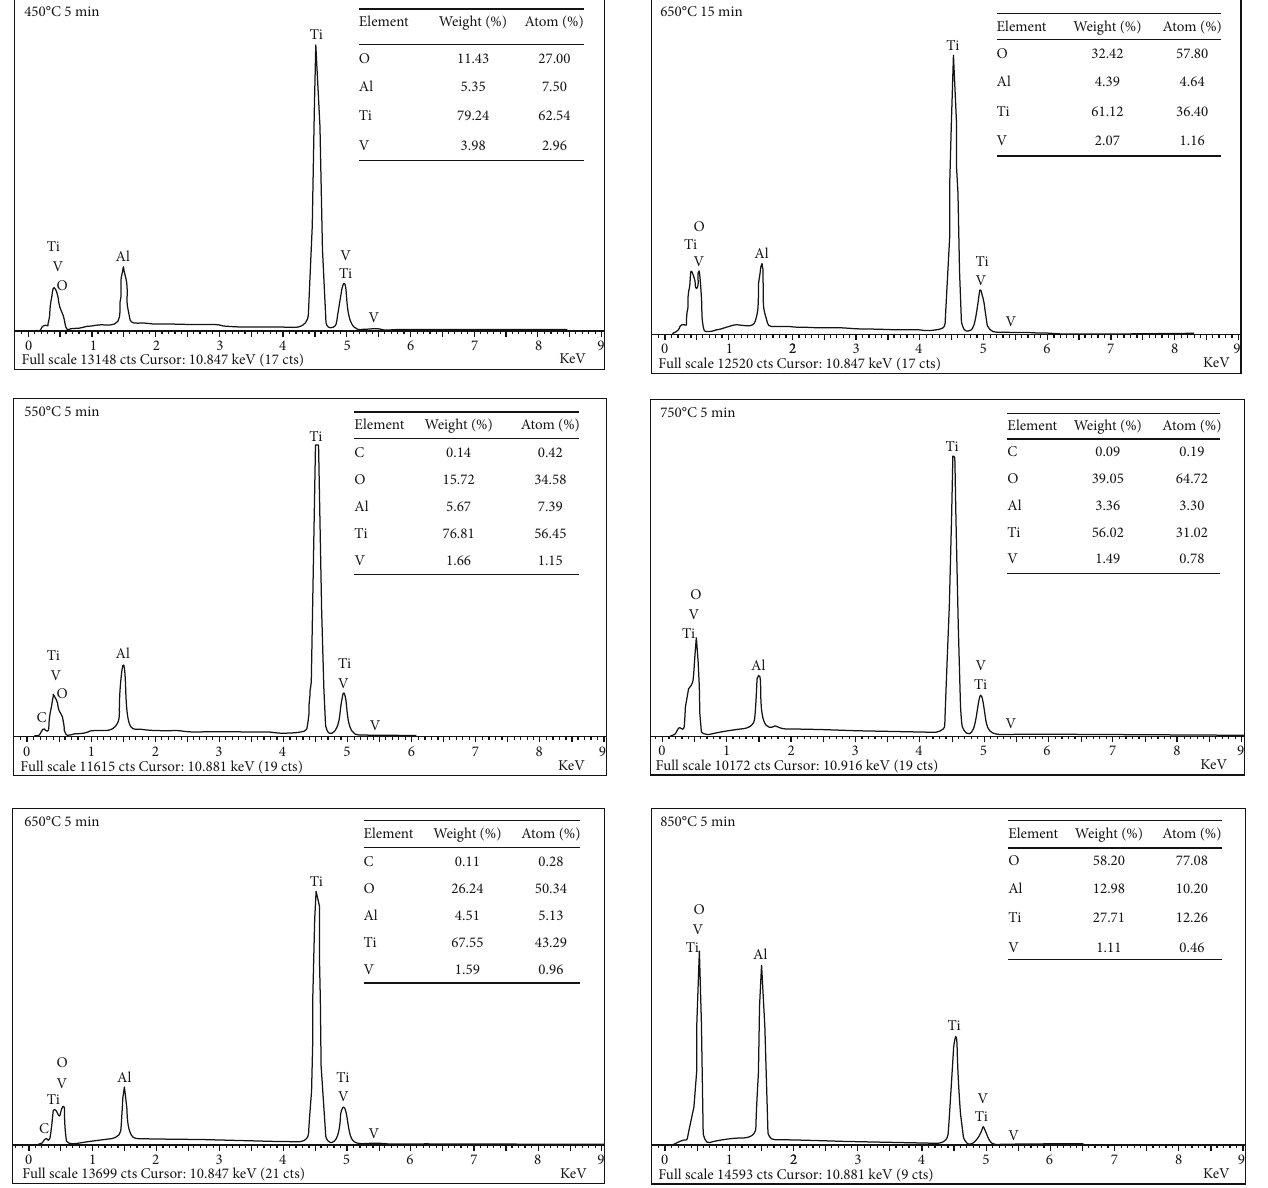
Figure 7: EDS analysis of oxide layers at di ff erent temperatures and